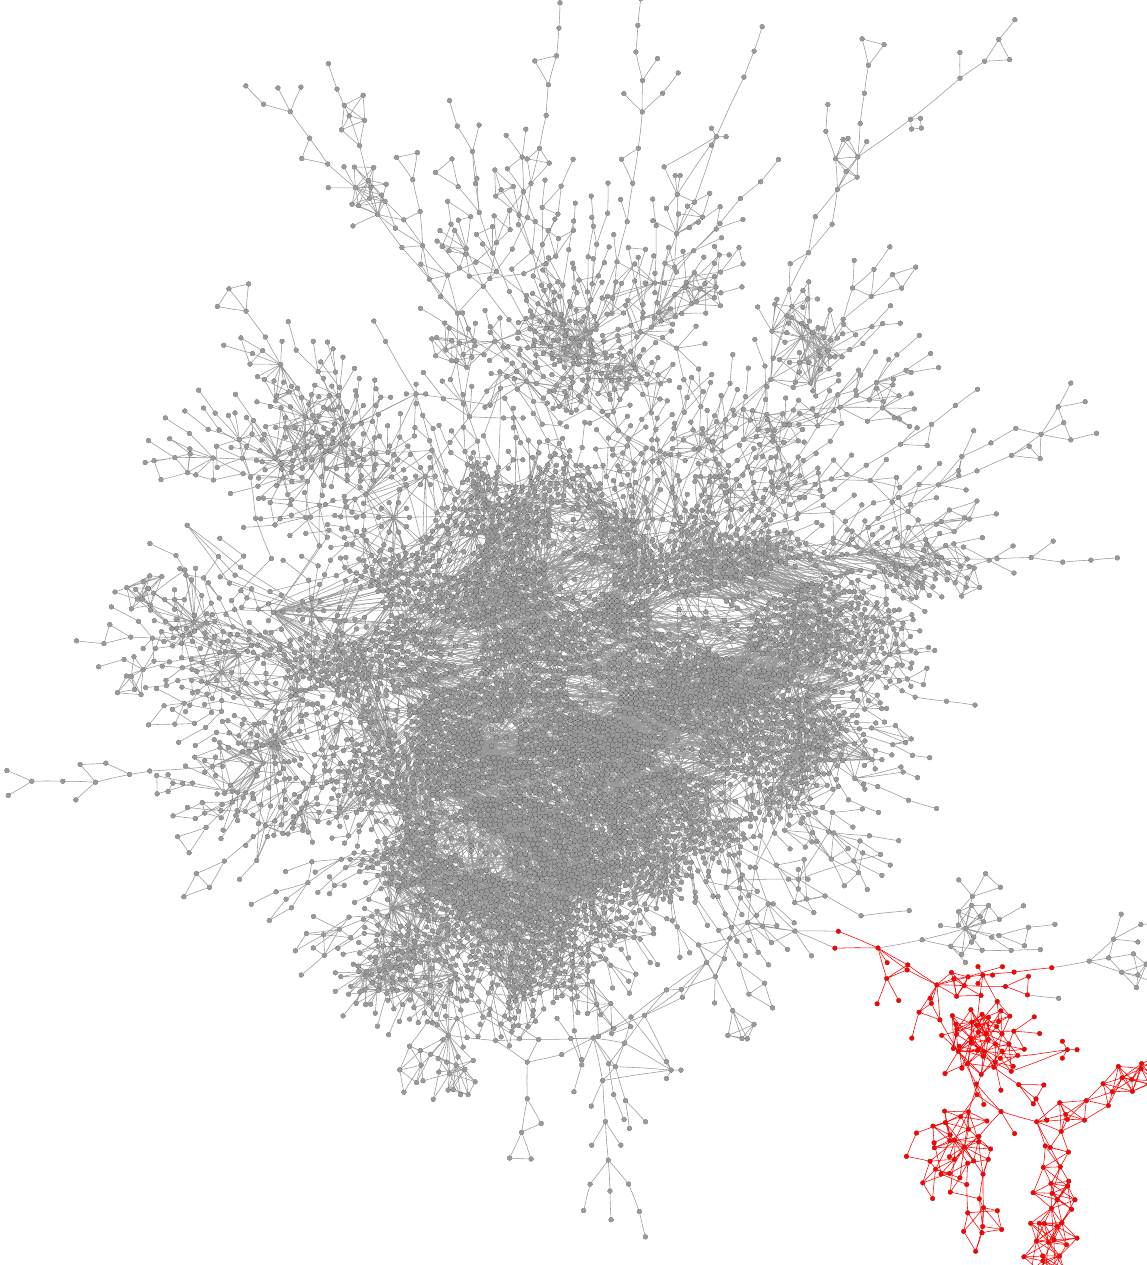
Figure 10. Local community (red) detected in the Amazon product co-purchasing network, using the proposed method. Here we show only 6701 nodes among the total 334,863 nodes (about 2% fraction) that are closest to the seed